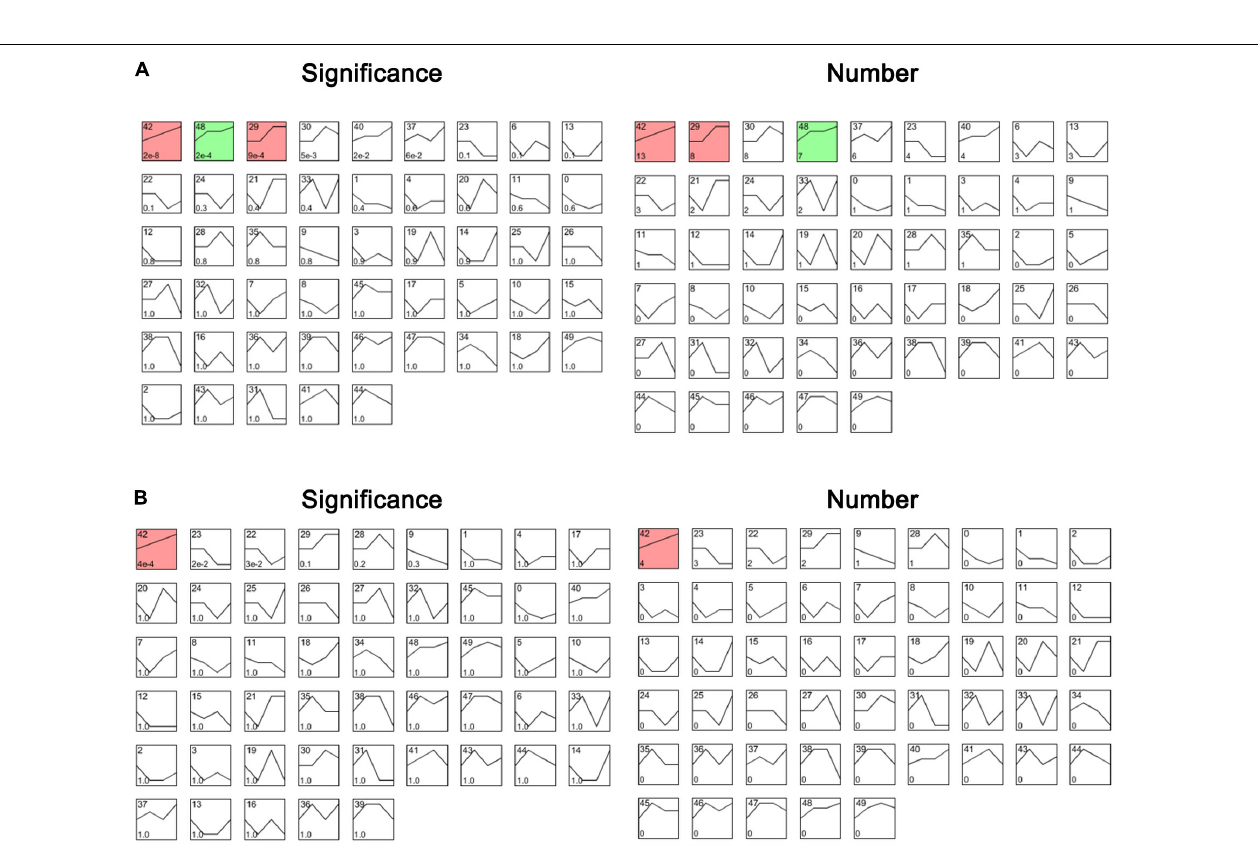
FIGURE 10 | The profiles of cluster analysis based on the expression profiles in the whole root of A. thaliana . (A) The profiles of cluster analysis by STEM based on the 102 genes in calcium-related gene families ranked by significance and number of genes. (B) The profiles of cluster analysis by STEM based on the DEGs associated with calcium ranked by significance and number of genes. The numbers 0–50 in the upper left refers to a serial number of profiles; The number of genes was shown in the lower left; The significance of each profile was described by P -value.